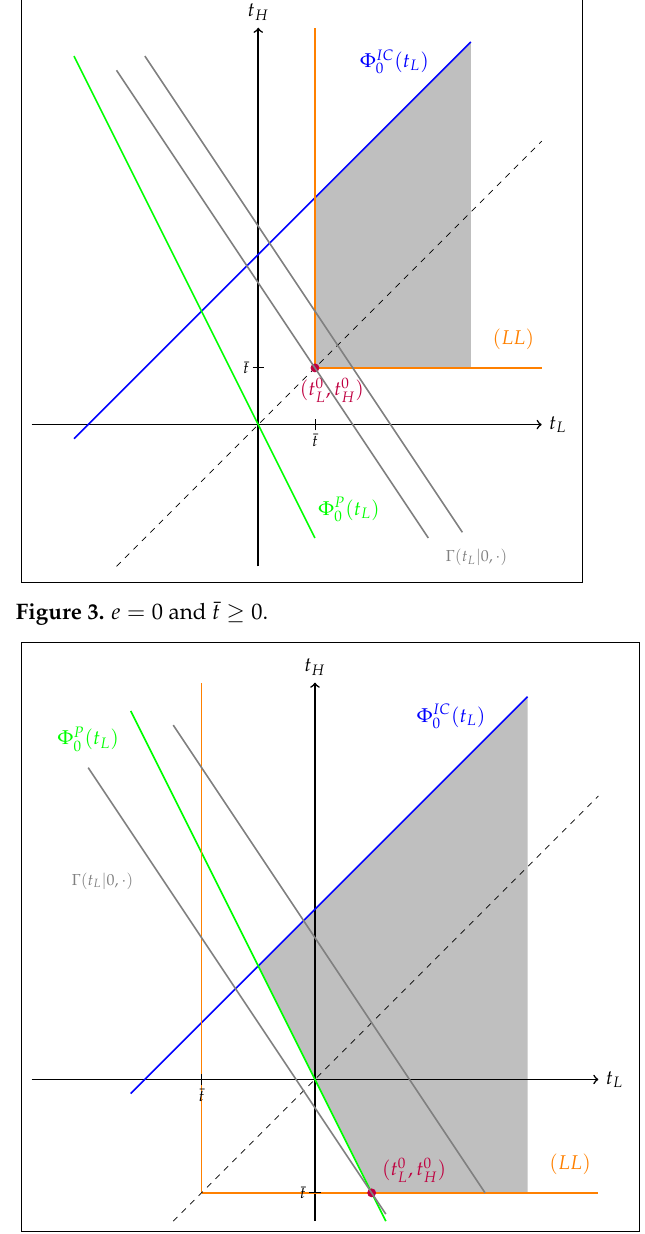
Figure 4. e = 0 and ¯ t <